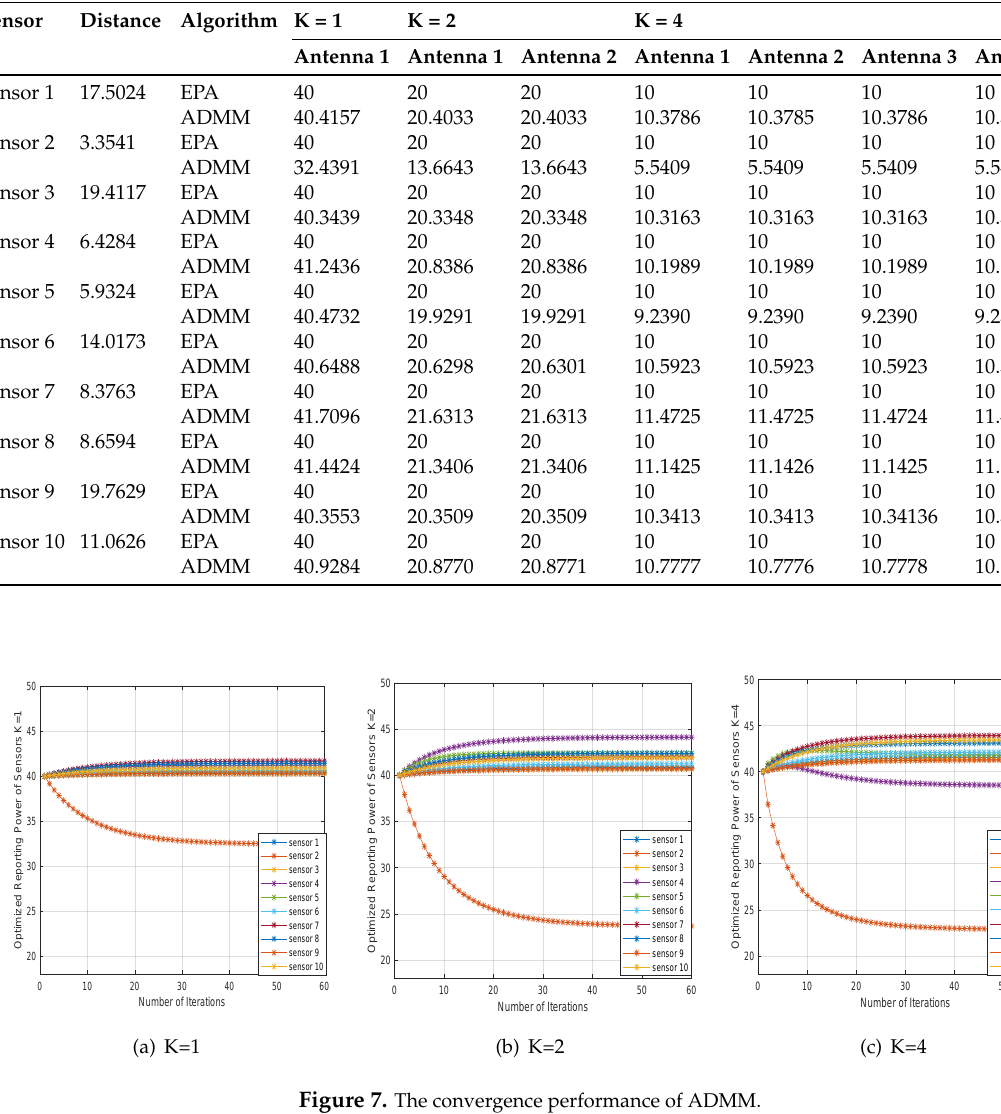
Figure 7. The convergence performance of